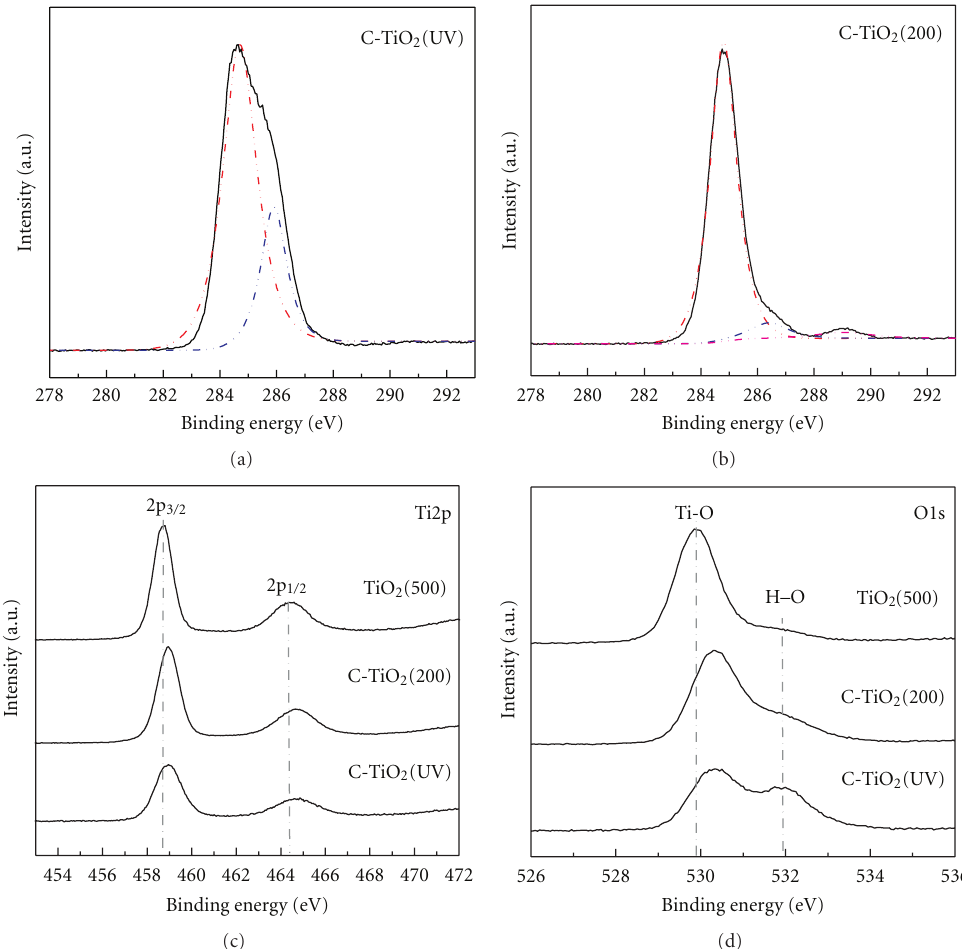
Figure 5: High-resolution XPS spectra of C1s for (a) C-TiO 2 (UV) and (b) C-TiO 2 (200); high-resolution XPS spectra of (c) Ti2p and (d) O1s for C-TiO 2 (UV), C-TiO 2 (200), and TiO 2 (500).